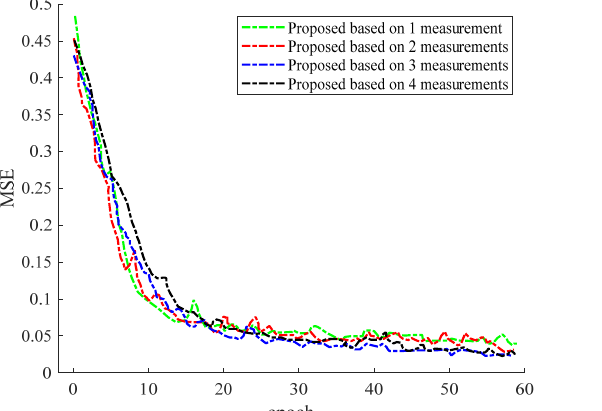
Figure 12. MSE performance of the proposed prediction scheme (Conv-GRU) when different numbers of inputs are used.